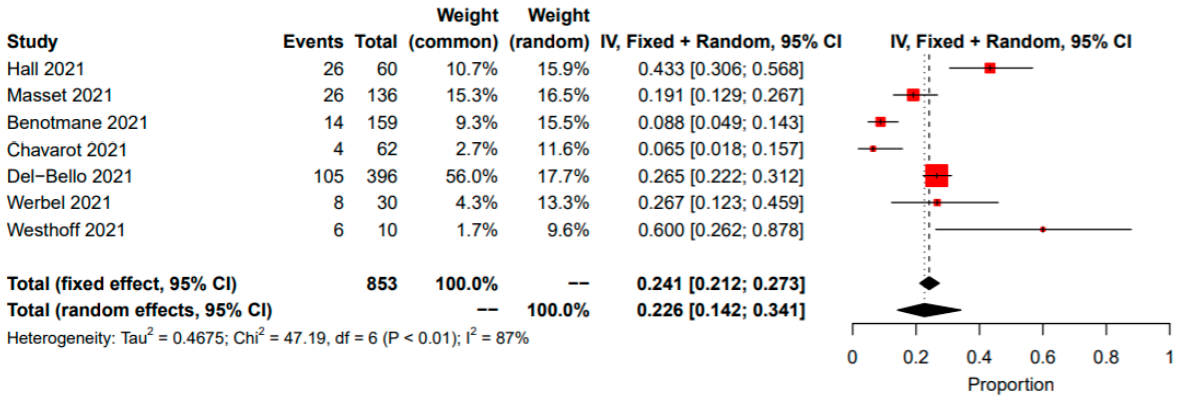
Figure 3. Proportion of seroconversion between the second and third doses of COVID-19 vaccine in solid organ transplant recipients. CI, confidence interval; IV, inverse variance.